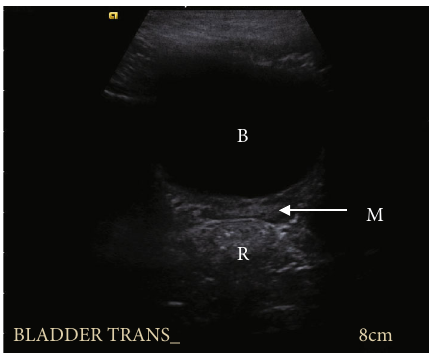
Figure 2: Müllerian remnant viewed on surveillance pelvic ultrasound scan. Key: M: Müllerian remnant; B: bladder; R: